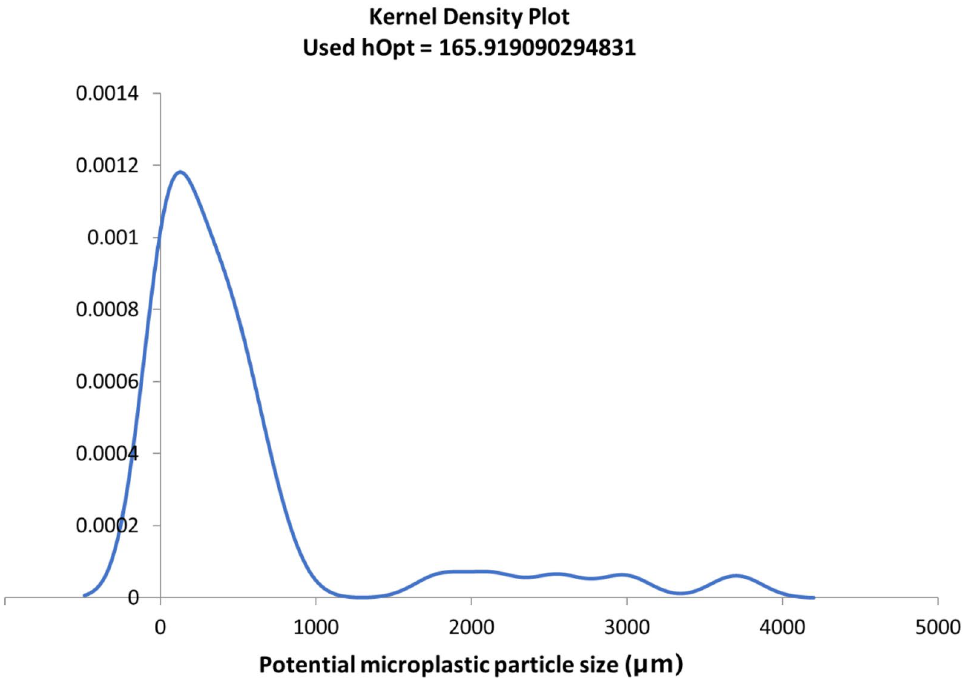
Figure 2. Kernel density estimation of potential microplastic size distribution based on 40 out of 58 particles extracted with NaCl density separation from whitefish fishmeal (n = 6). 87.2% were microparticles ≤ 1000 µm and 12.8% microparticles 1000–5000 µm. Note: the single > 5000 µm particle (6436 µm) is excluded from microplastic